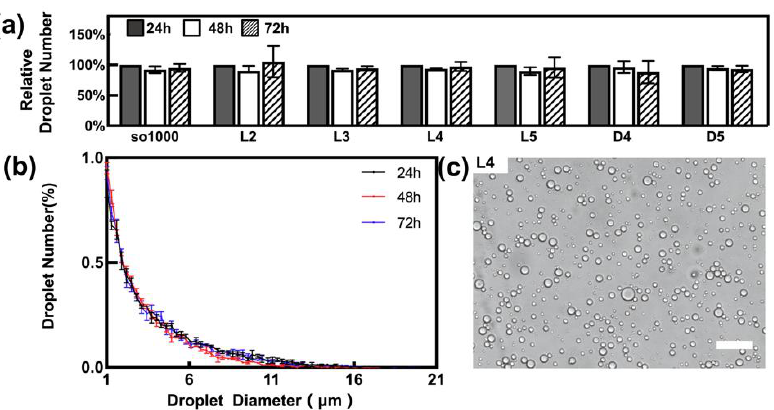
Figure 1. SilOil emulsion generated by high-speed homogenisation: ( a ) the number of emulsified droplets (relative to the number of droplets on Day 1) of various types of LMWC within 72 h after generation; ( b ) the representative emulsified droplets distribution profile of L4 with highly overlapped curves within 72 h after generation; ( c ) the representative morphology of emulsified droplets under fluorescence microscope. Scale bar = 50 µ m. The results in ( a – c ) are representative of those from 3 independent experiments with 5 replicates